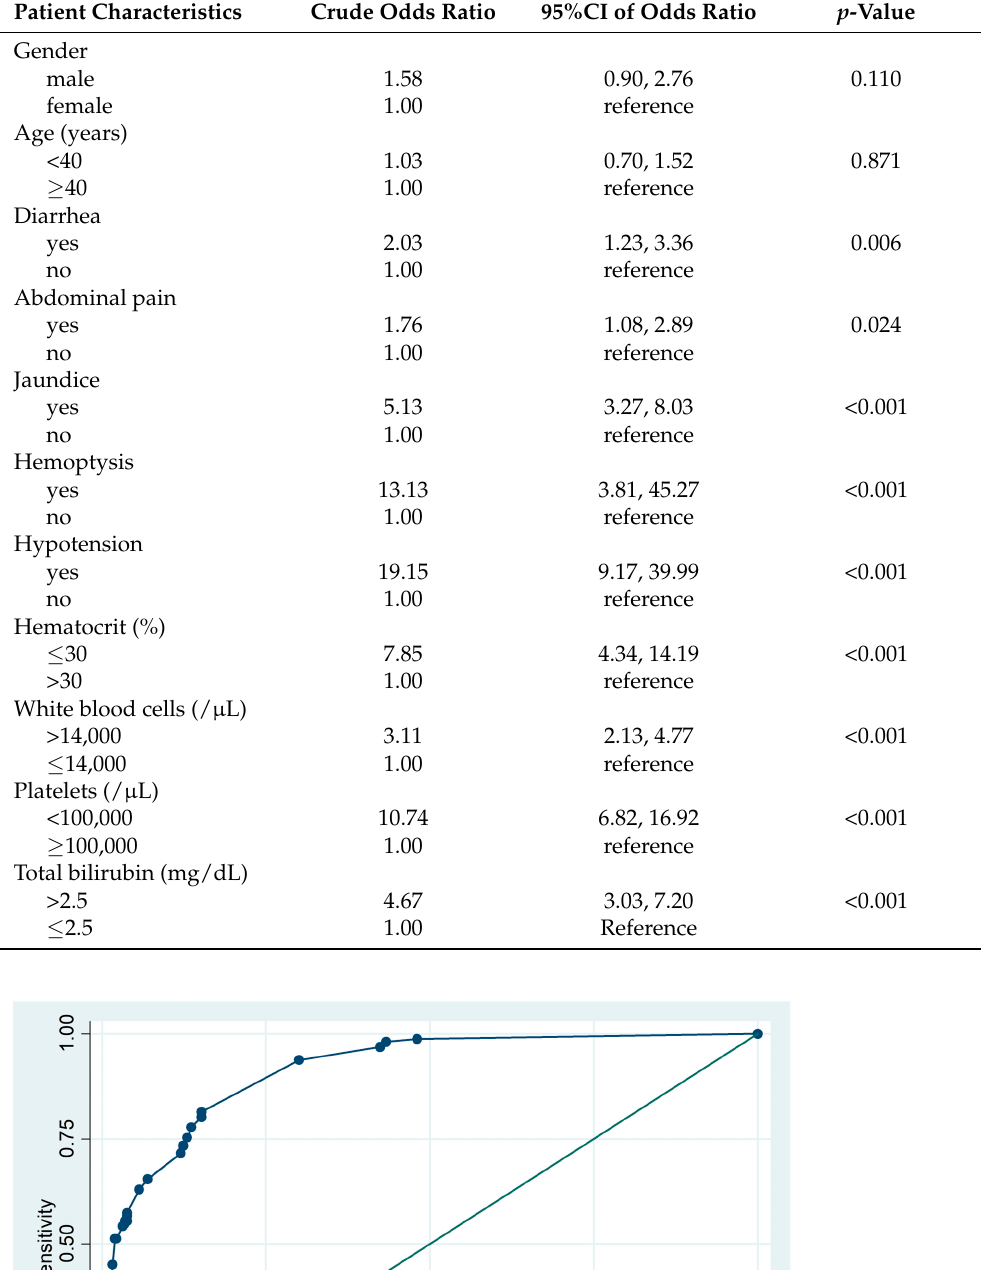
Table 2. Crude odds ratios (OR) and 95% confidence interval (CI) for leptospirosis infection.